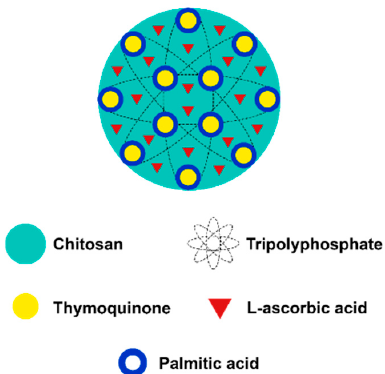
Figure 1. Proposed illustration of hydrophobically modified palmitoyl-chitosan nanoparticles encapsulated with hydrophobic thymoquinone and hydrophilic l -ascorbic acid, palmiltoyl-chitosan nanoparticles (PCNP)-thymoquinone (TQ)- l -ascorbic acid (LAA).